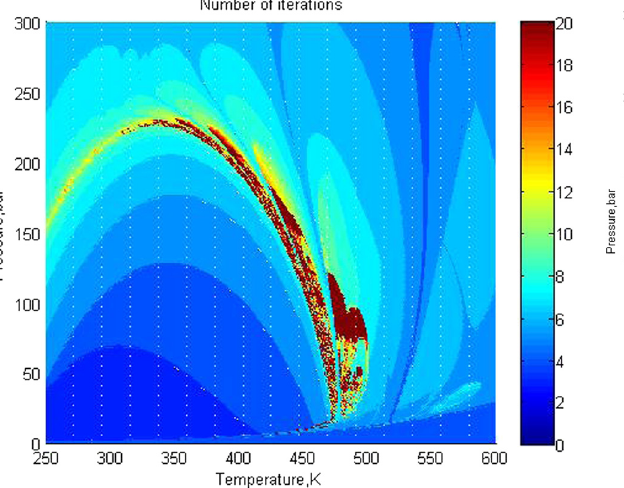
Figure 3: Number of iterations for the MY10 mixture, NBH method with type L initialization.